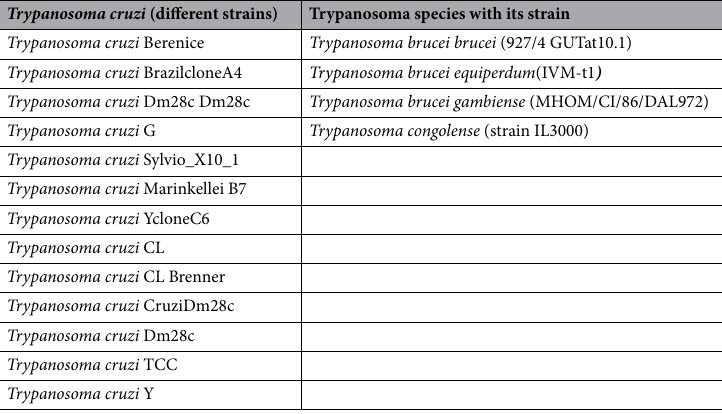
Table 2. Different strains and species of Trypanosoma used for the identification of key vaccine